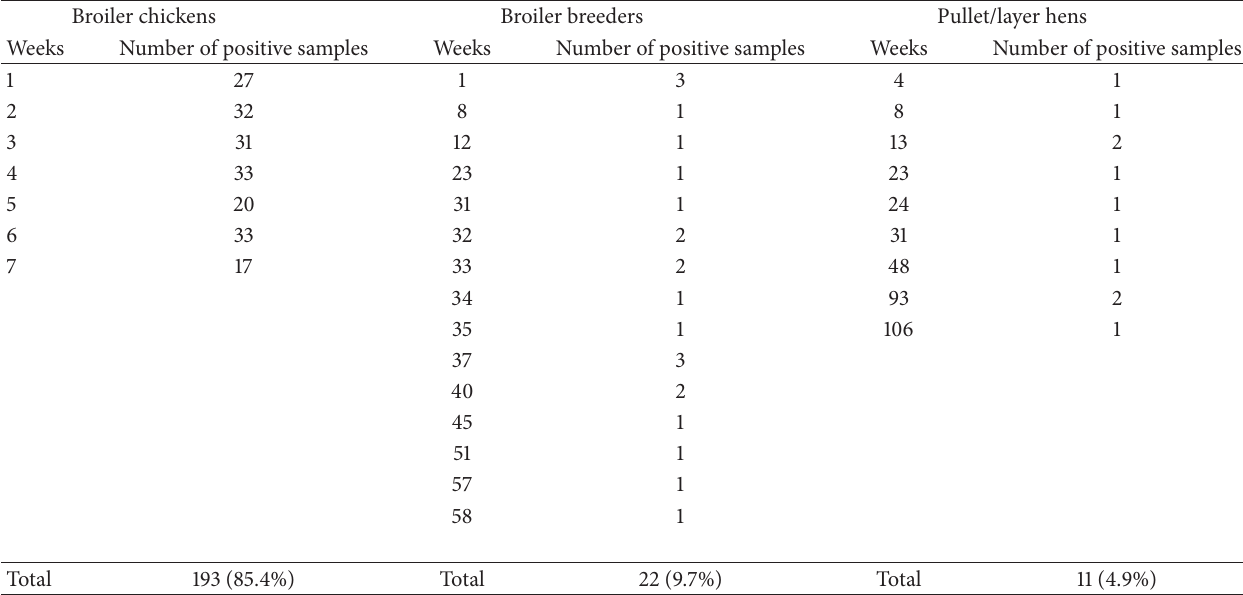
Table 4: Positive samples for one or more viruses obtained from broiler chickens, breeders, and layer hens and the respective age in weeks at chicks which were